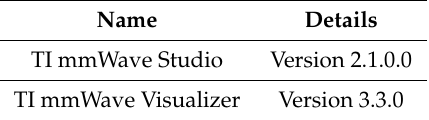
Table 2. List of